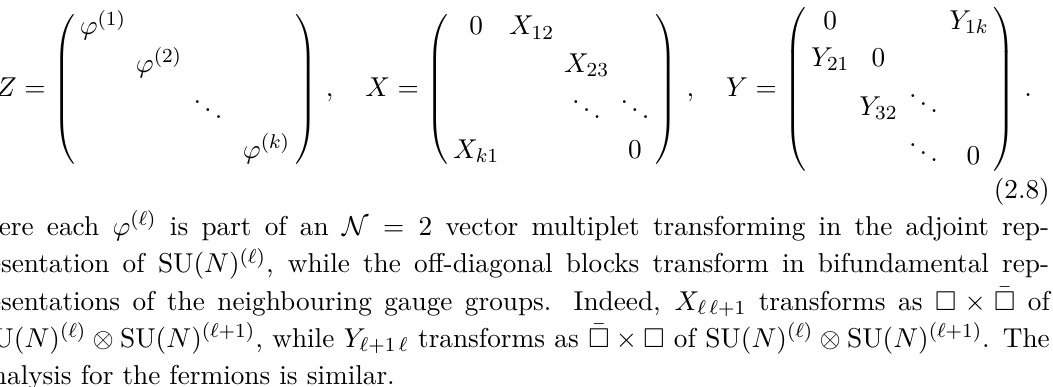
Figure 2 . The quiver diagram for the Z 2 orbifold